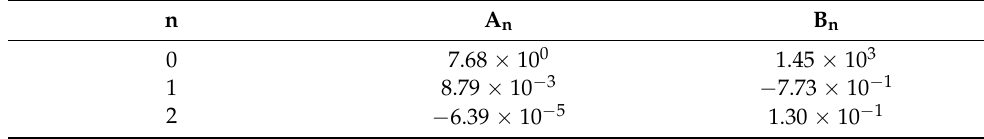
Table A40. Coefficients of the CH 3 OH-LiBr saturated pressure